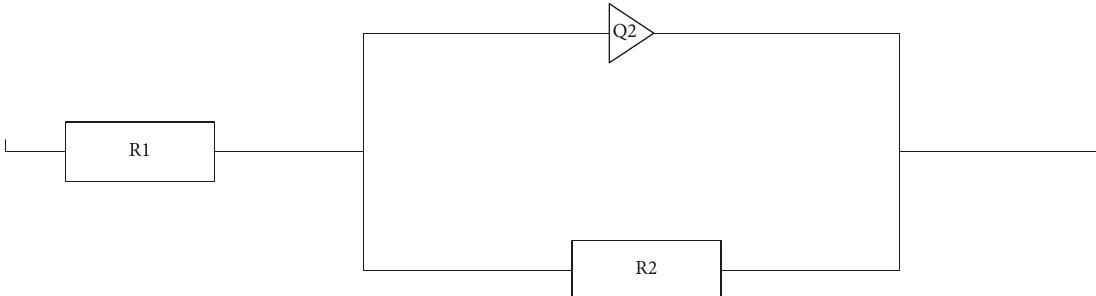
Figure 10: The electrical equivalent circuit model of Ti-6Al-4V in 0.5MH2SO4 at 30.0 °